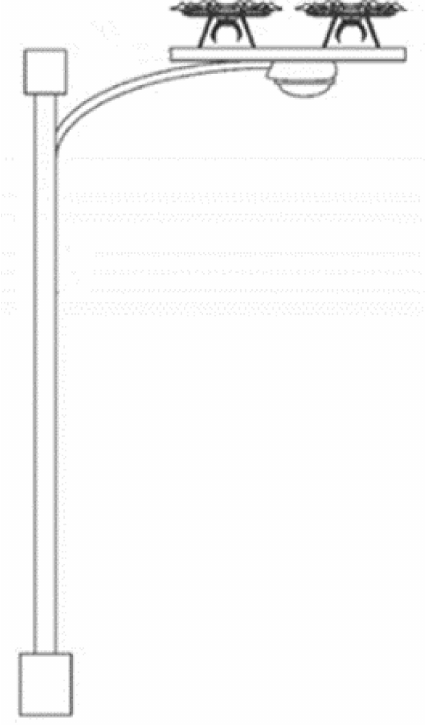
Figure 13. Drone docking stations on lamp posts